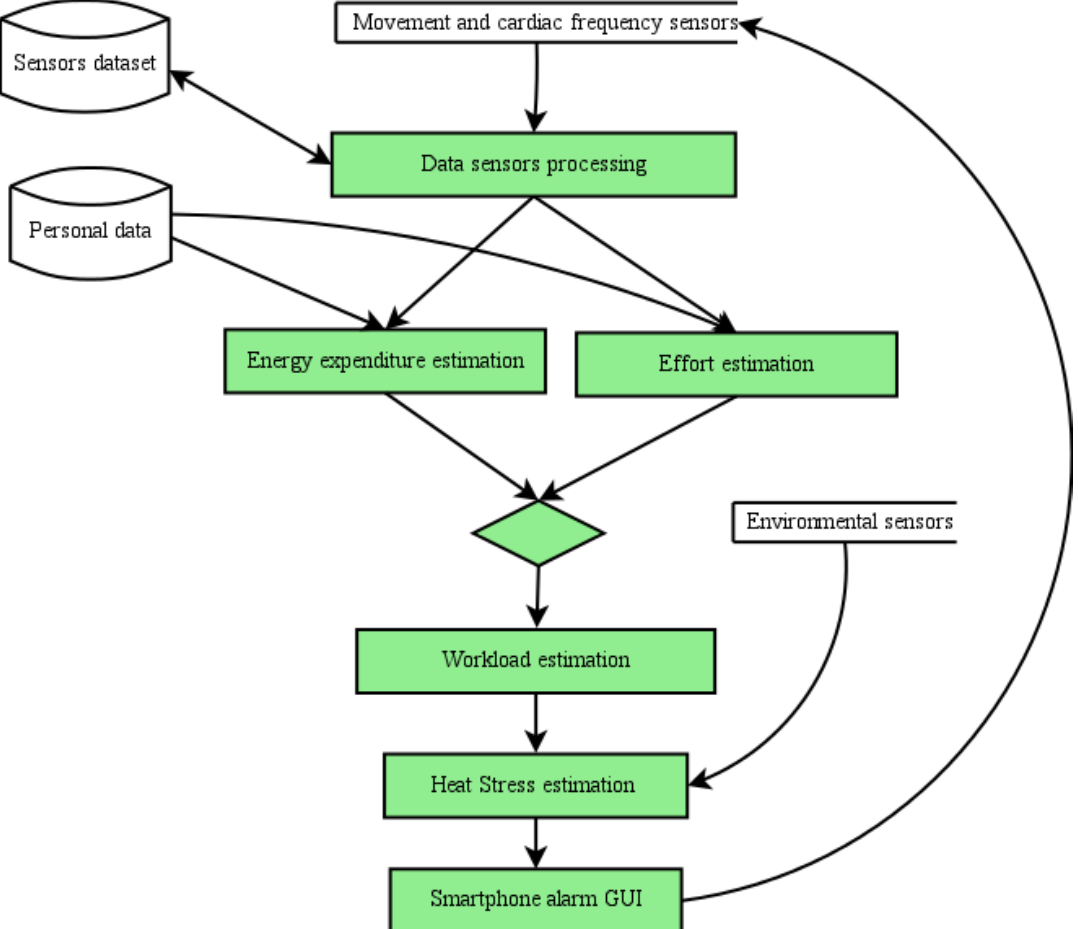
Figure 2. Occupational heat stress (OHS) monitoring